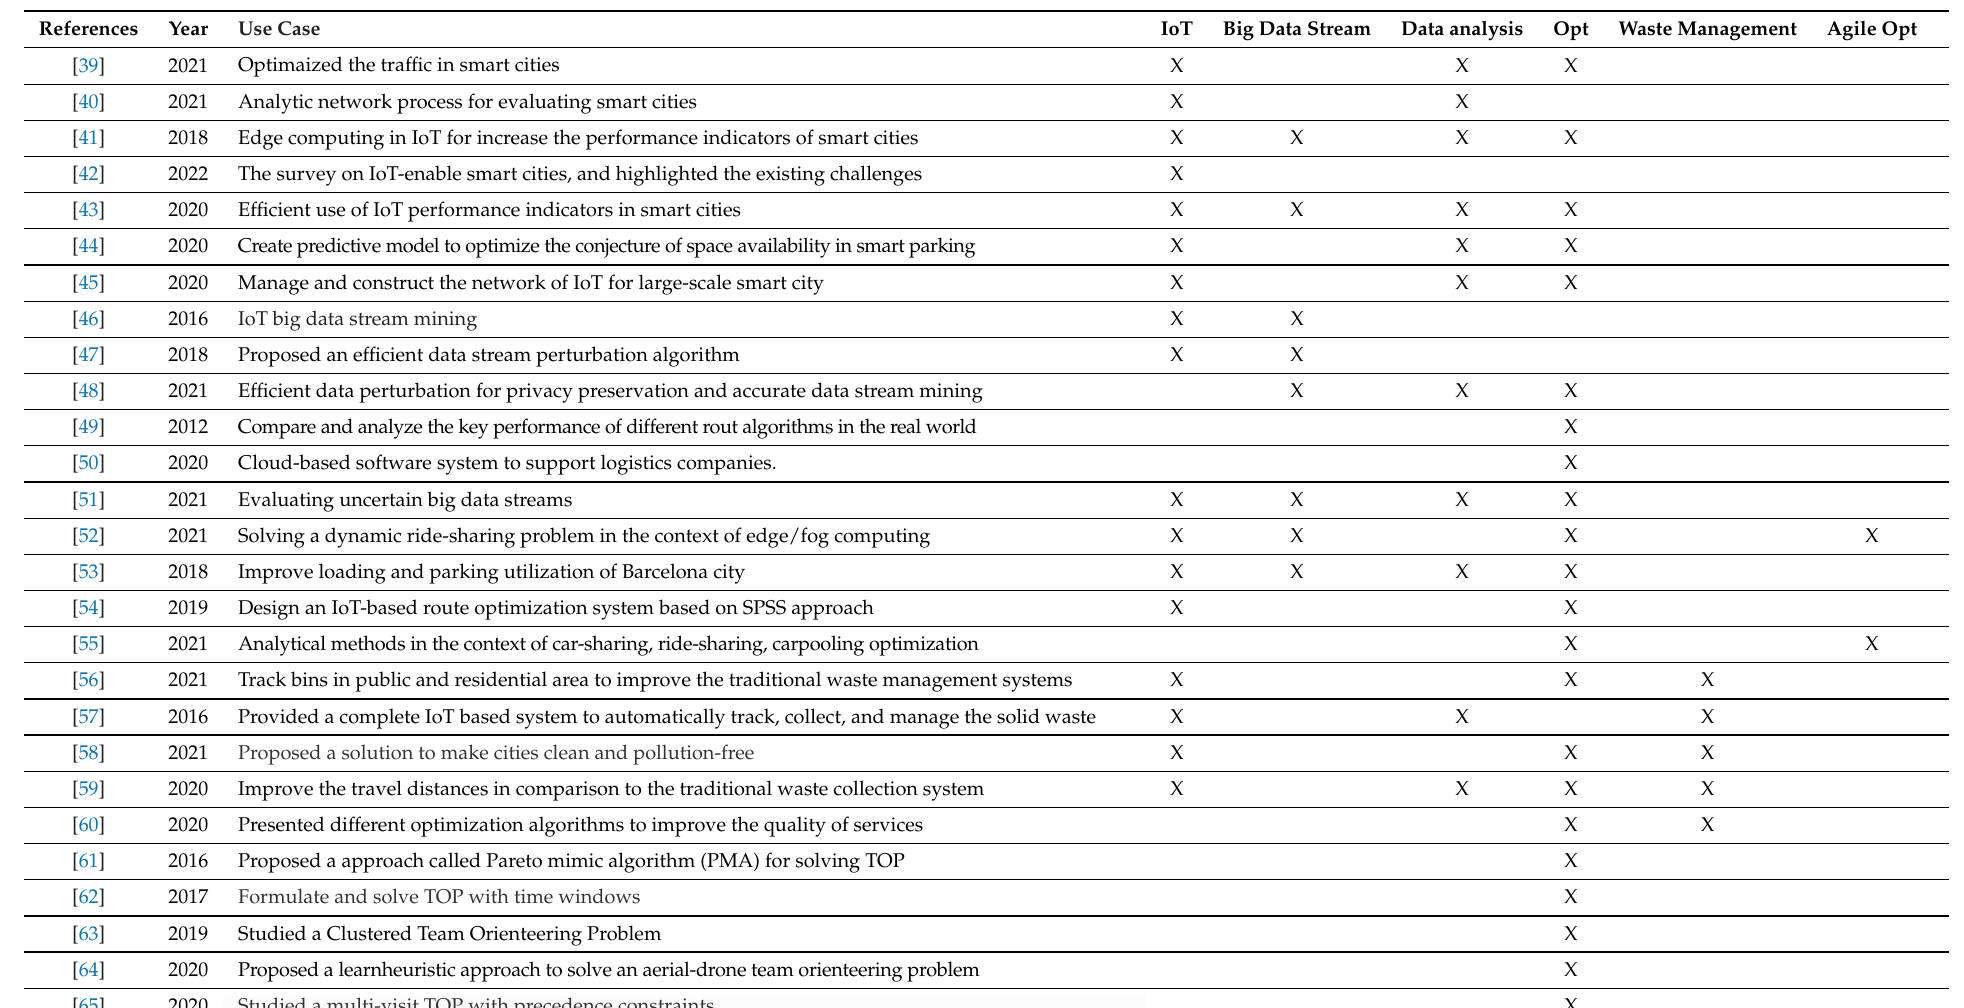
Table 1. Comparison of the reviewed